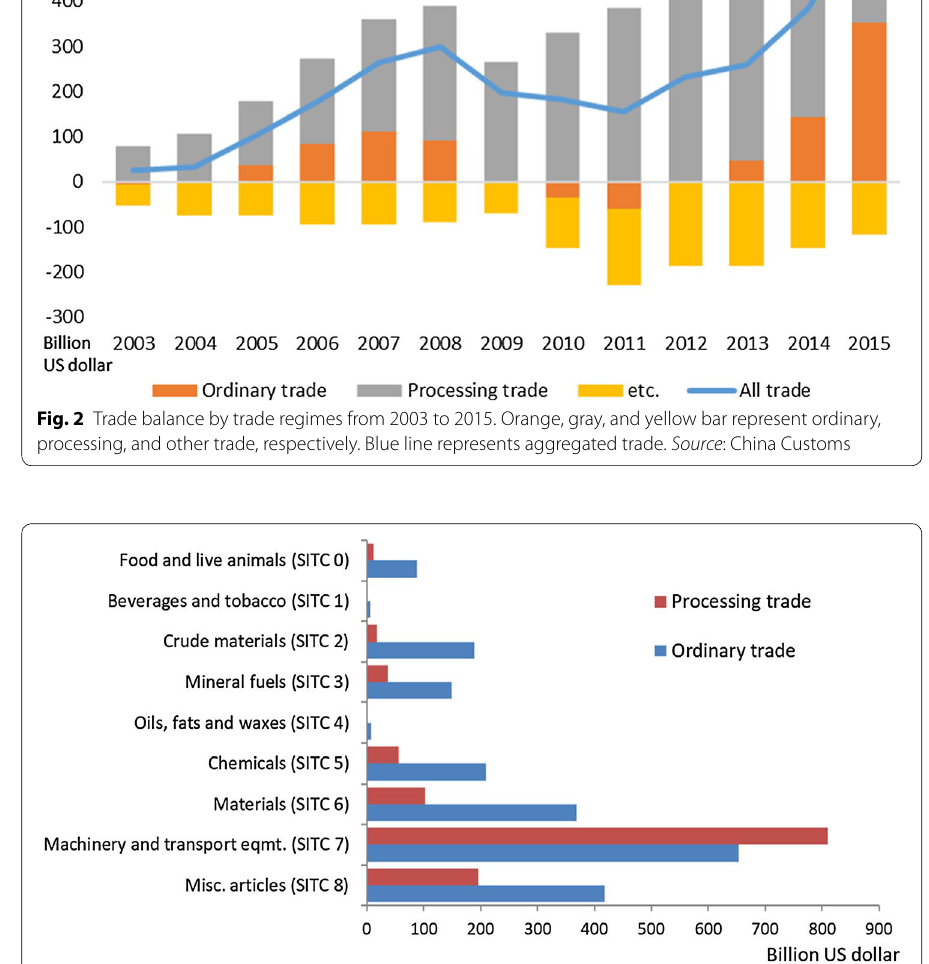
Fig. 3 Composition of processing and ordinary trade by industries in 2015. Blue and red bar represent